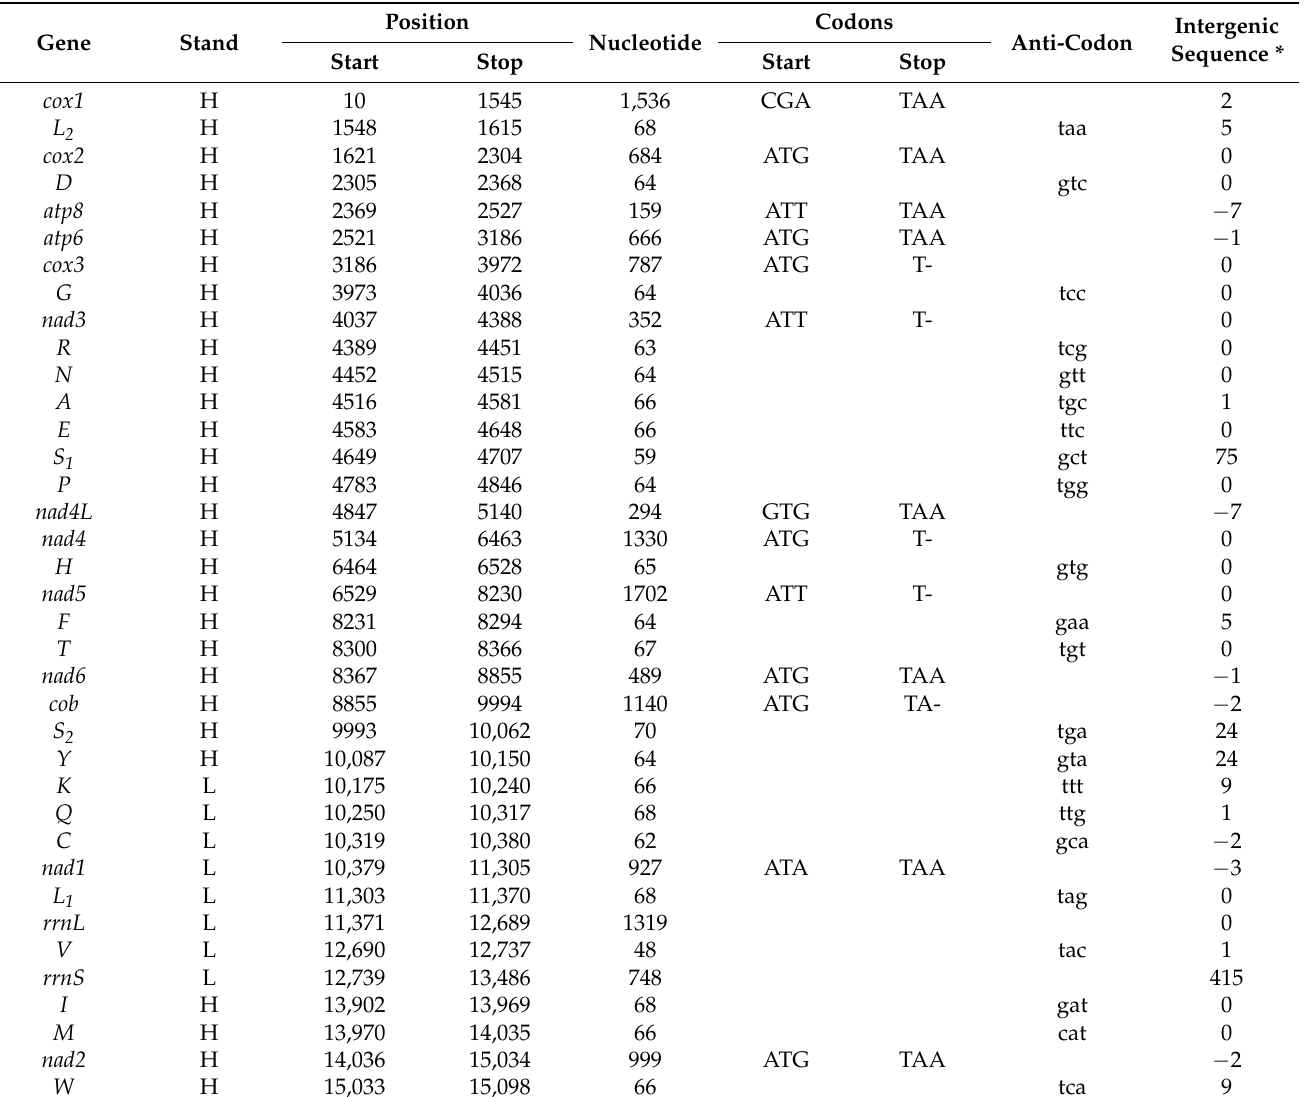
Table 2. The mitochondrial genome of M. coccopoma